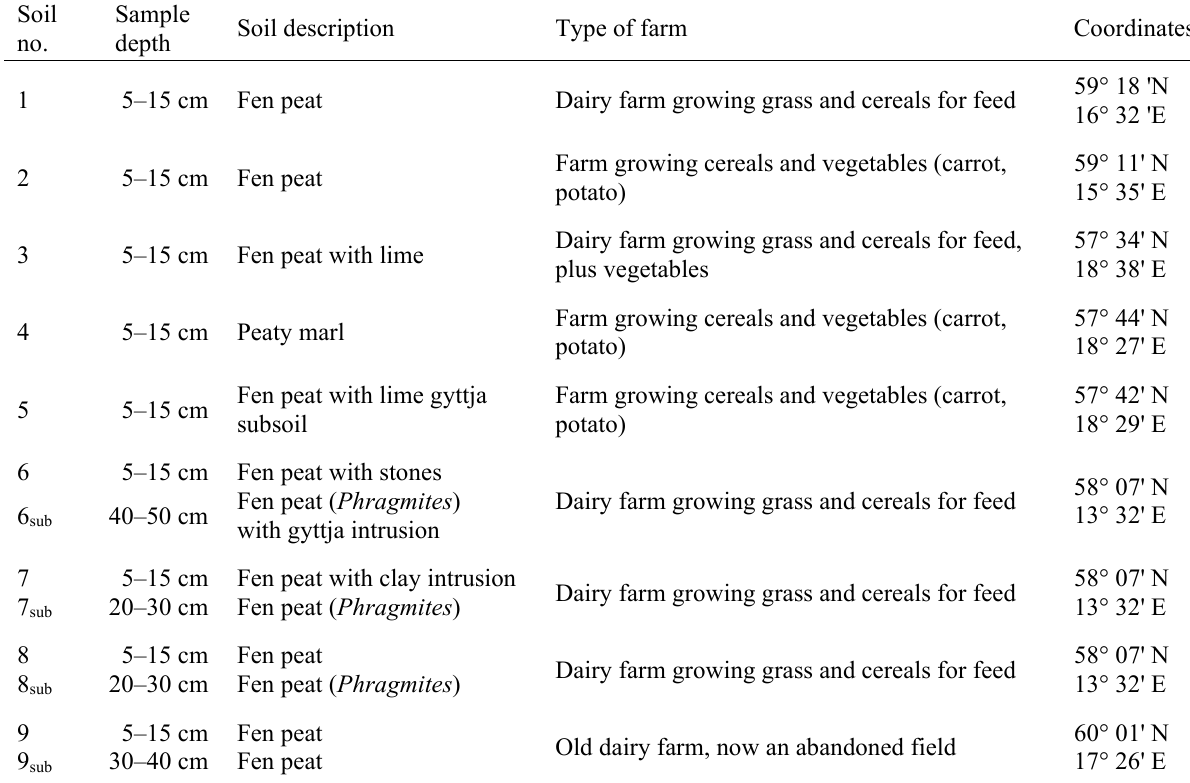
Table 1. Descriptions of the soils and farm types at the sampling sites in Sweden. Topsoil samples only were taken at five sites (Soils 1–5), and topsoil plus subsoil samples were taken at four sites (Soils 6–9). Subsoil samples are marked “sub”.